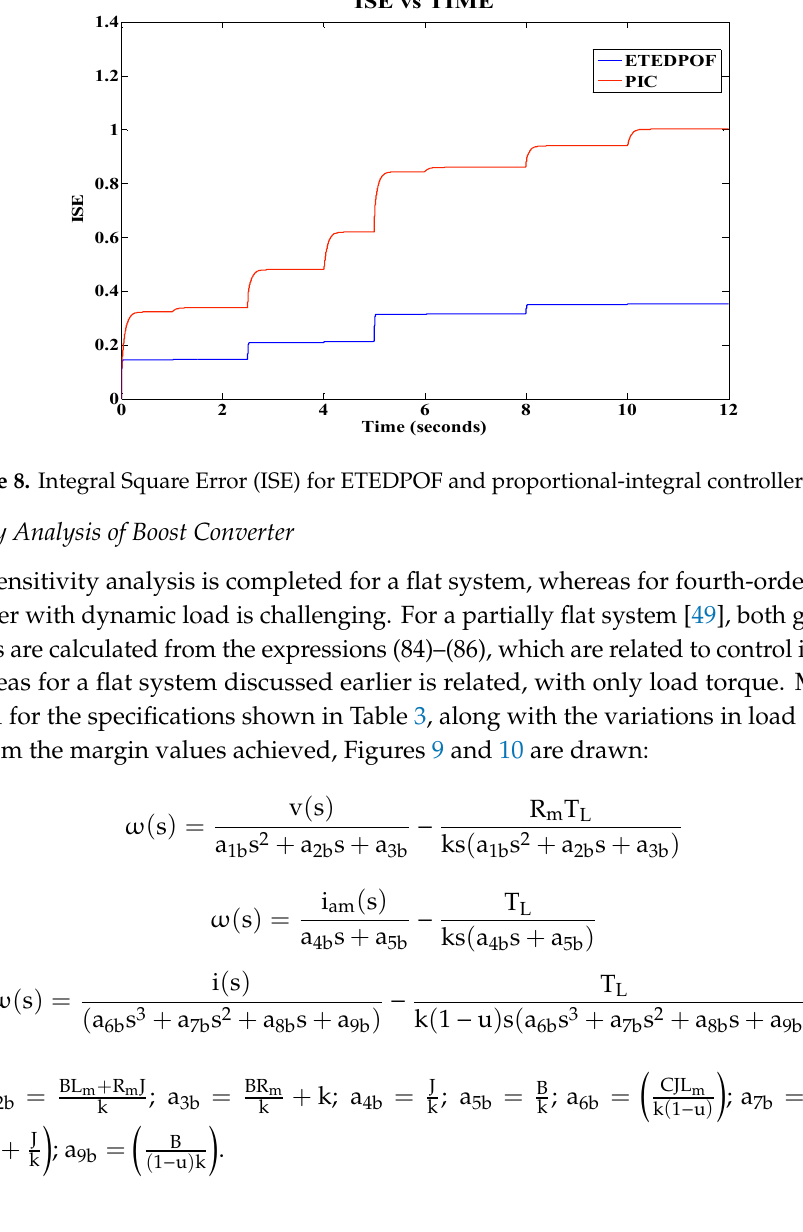
Figure 7. ( a ) Speed response (simulation); ( b ) speed response (hardware).